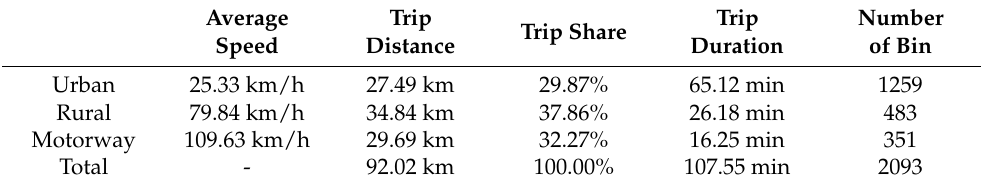
Table 4. Trip information analysis.